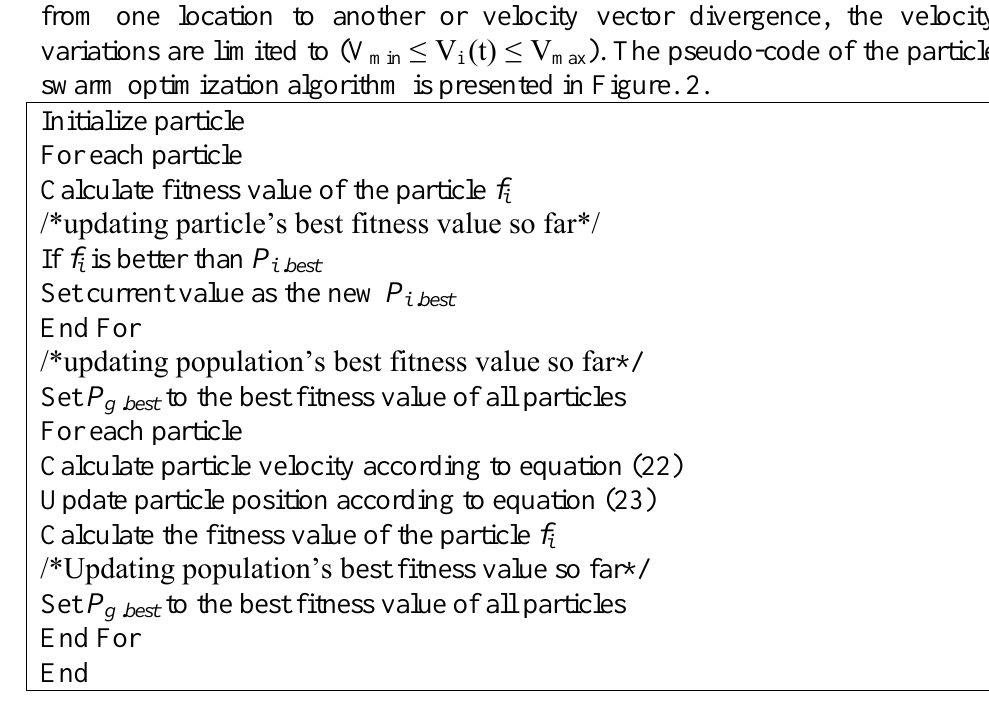
Figure 2. The pseudo code of particle swarm optimization algorithm